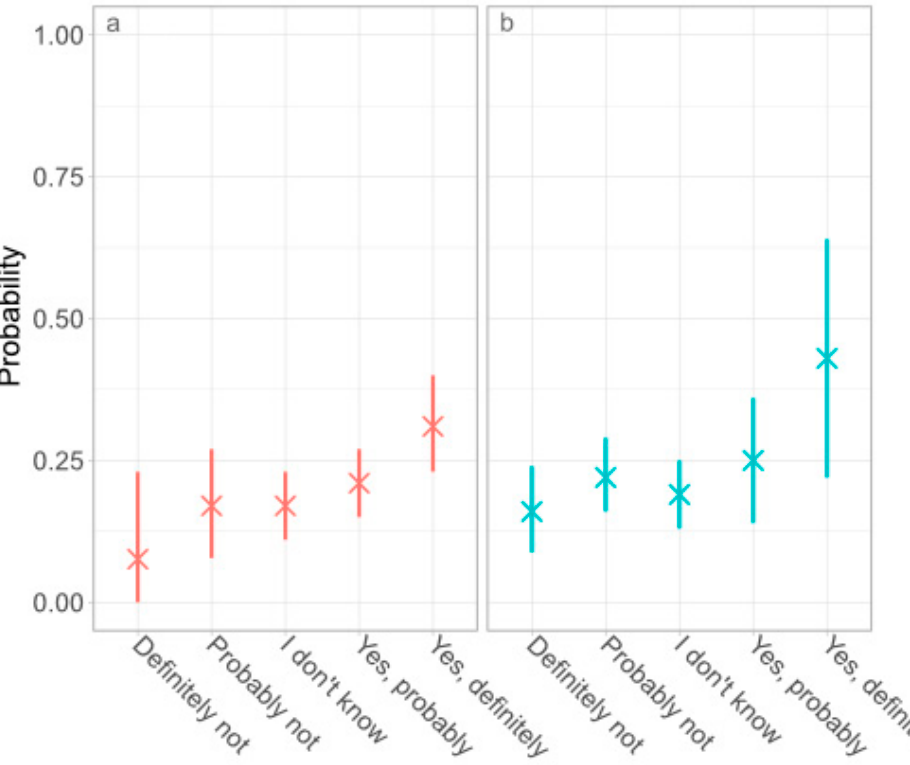
Figure 1. Adaptation by the experience of climate change. Estimated probability of decision-making favouring adaptation to climate change by strength of belief that one has experienced impacts of climate change: ( a ) negative experience (Bayesian robust correlation ρ = 0.83; 95.6% probability of a positive correlation) and ( b ) positive experience (Bayesian robust correlation ρ = 0.66; 90.4% probability of a positive correlation) of climate change impacts (Q3, Q4, and Q7 in Table 1). Table 2. Tipping point behaviour in relation to decisions favouring responding to climate change (adaptation and mitigation).